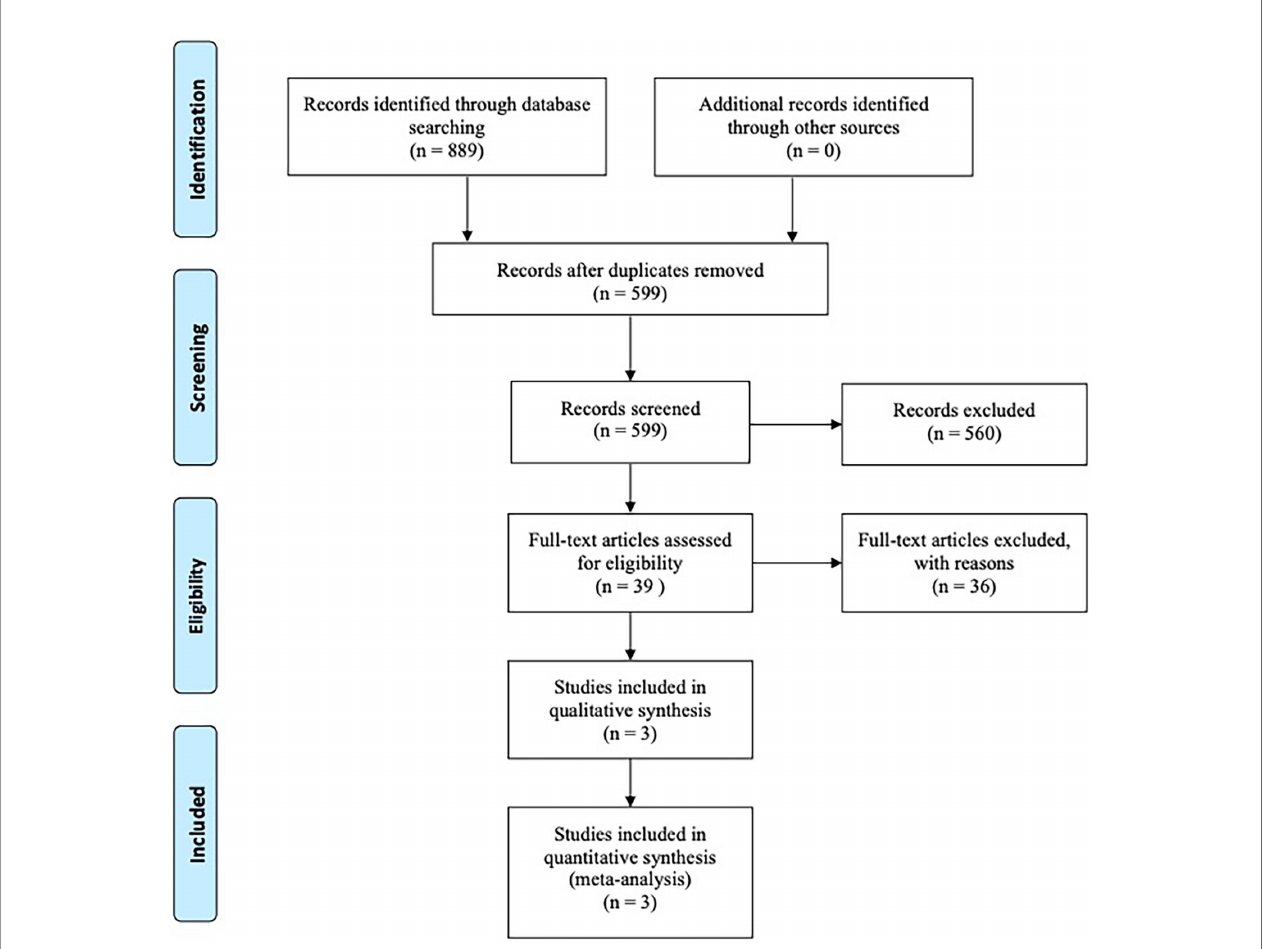
FIGURE 1 | Articles retrieved and assessed for eligibility. After screening process, three RCT articles met the including criteria and were included in ultimate